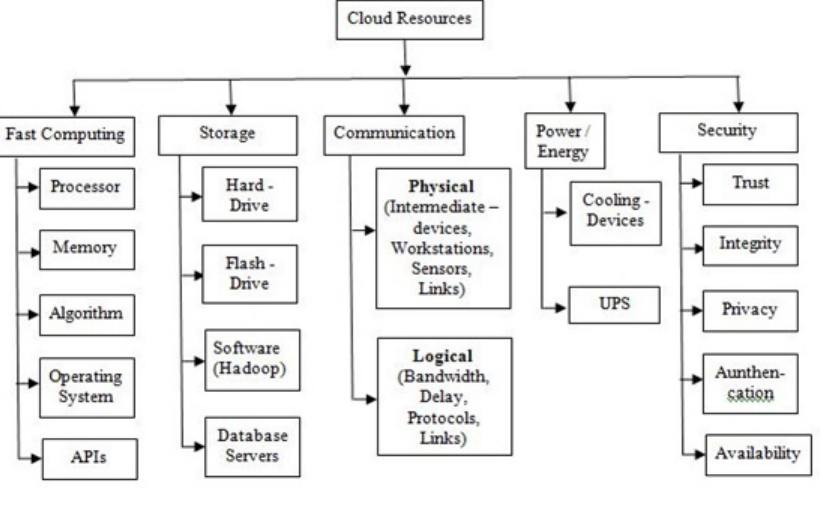
Figure 11. Classification of cloud resources